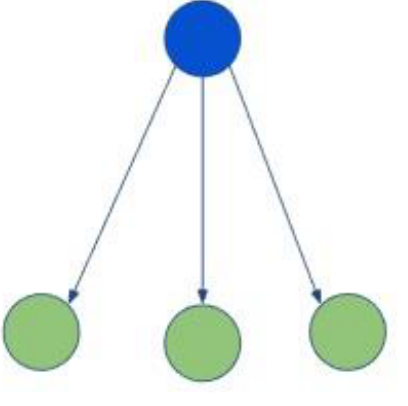
Figure 8. Visual representation of course developer